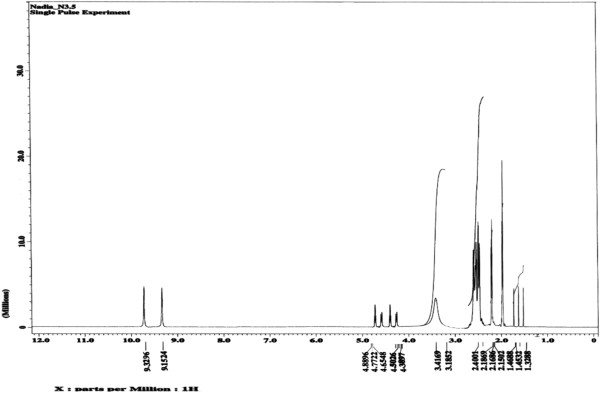
1H NMR spectrum for epoxidized ricinoleic acid (ERA) (2).